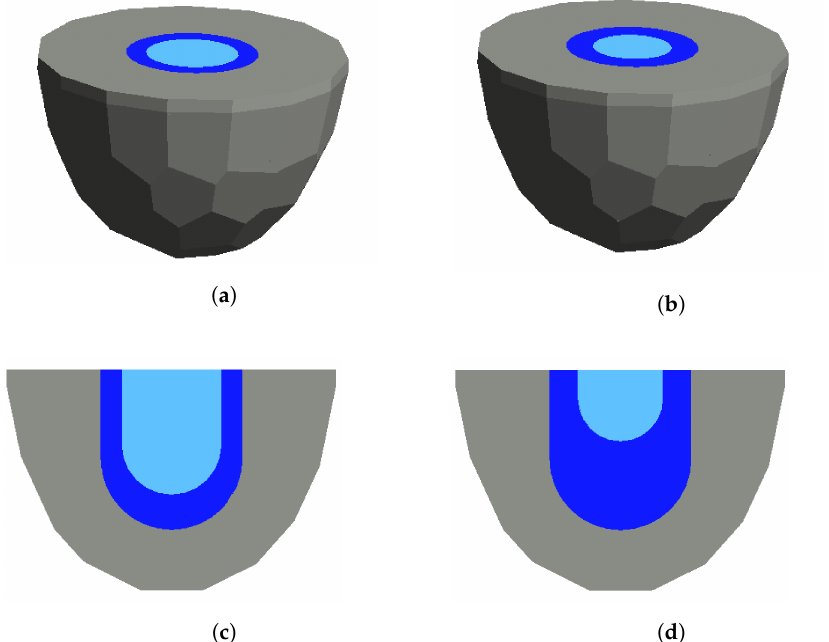
Figure 3. Renderings of interior of faceted air-filled chamber ( a , b ) and cross-section ( c , d ) showing the three regions: air (grey), fat (dark blue), fibroglandular (light blue), for a medium (left) and small (right) fibroglandular region.